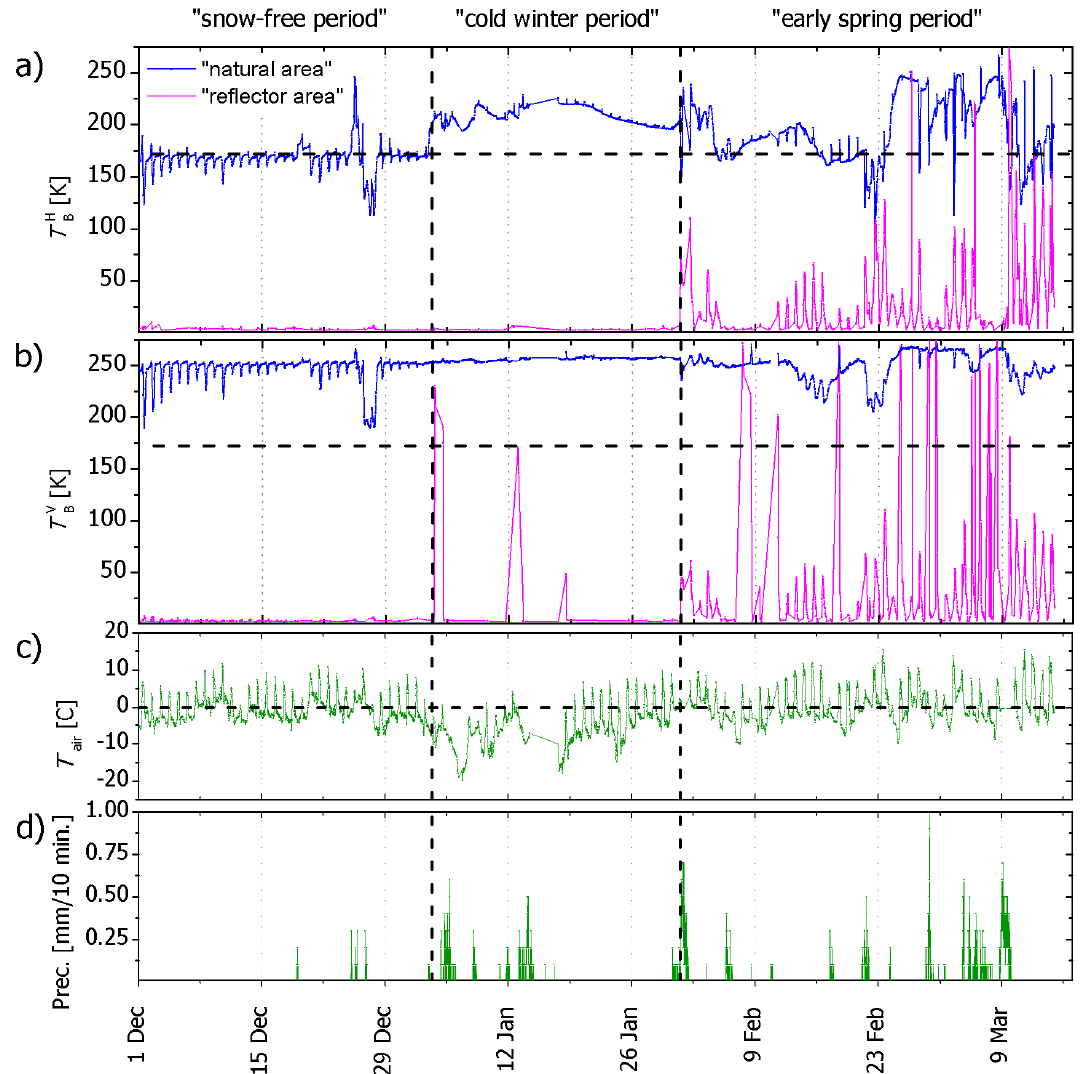
Figure 11. T p (blue) and T p (magenta) of brightness temperatures at: ( a ) horizontal ( p = H); B,N B,R and ( b ) vertical ( p = V) polarization measured over “natural” and “reflector” areas, respectively. Panels ( c , d ) show air temperature T air and precipitation rate, respectively. The vertical dashed lines delimit the “snow-free period” (before 3 January), the “cold winter period” (3–31 January), and the “early spring period” (after 31 January).